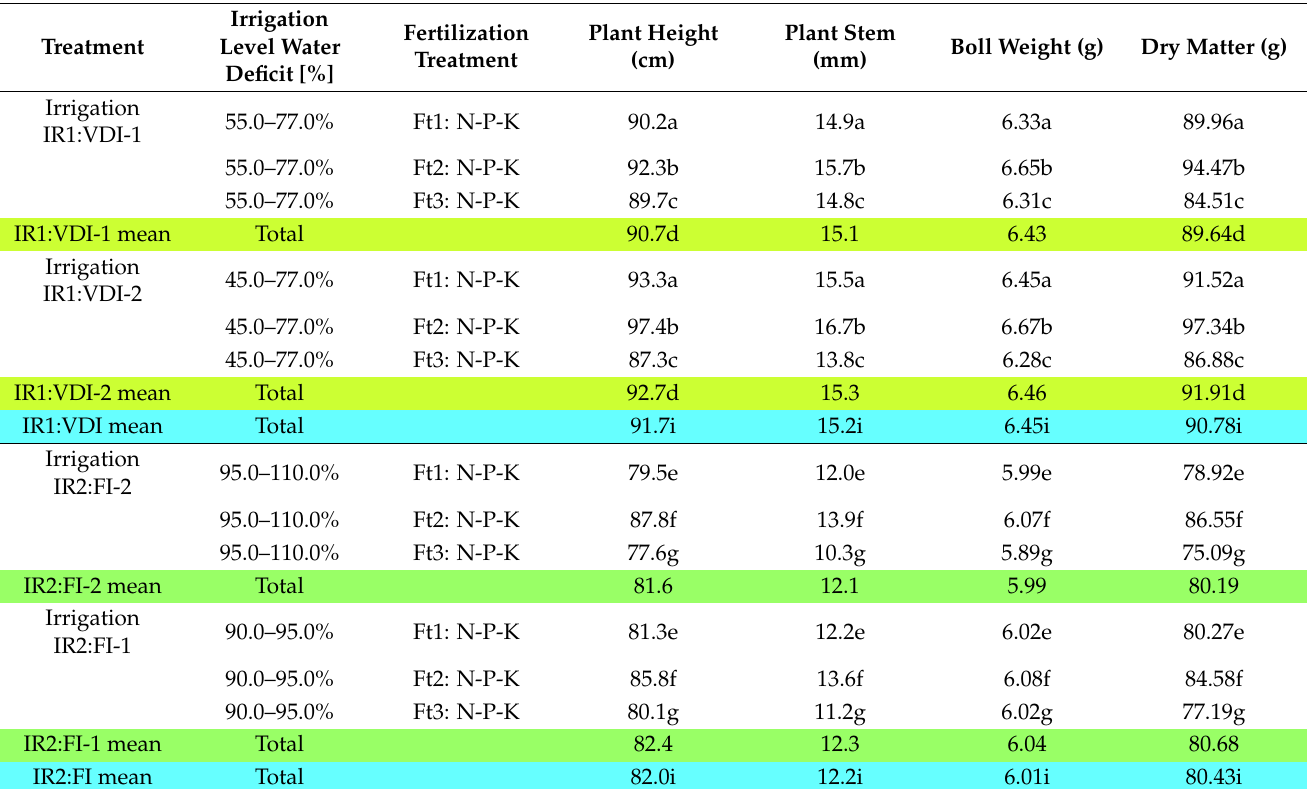
Table 4. Statistical analysis results of cotton plant growth characteristics for irrigation treatments IR1:VDI irrigation (VDI-1 and VDI-2) and IR2:FI irrigation (FI-1, FI-2) using three fertilization treat- ments (Ft1, Ft2, and